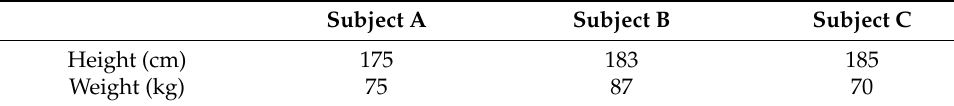
Table 1. Height and weight of testers.